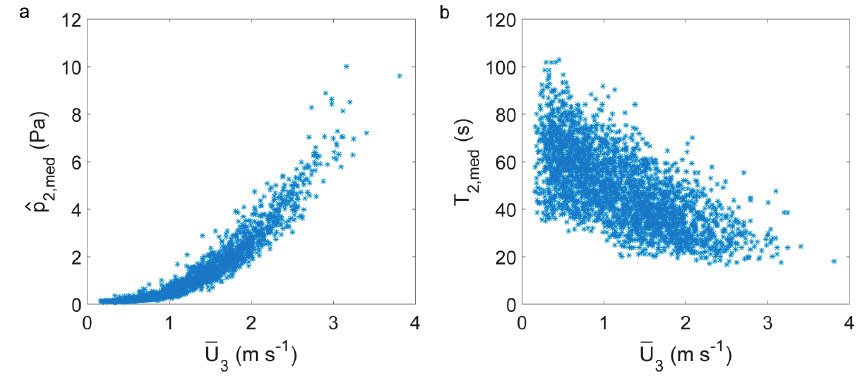
Figure 6. Dependence of ( a ) amplitudes of the medium frequency part of the air pressure signal measured at height (cid:1878) (cid:2870) ( (cid:1868)̂ (cid:2870),(cid:2923)(cid:2915)(cid:2914) ); and ( b ) dominating periods of the medium frequency part of the air pressure signal measured at height (cid:1878) (cid:2870) ( (cid:1846) (cid:2870),(cid:2923)(cid:2915)(cid:2914) ) on the mean above-canopy wind speed ( (cid:1847)(cid:3365) (cid:2871)